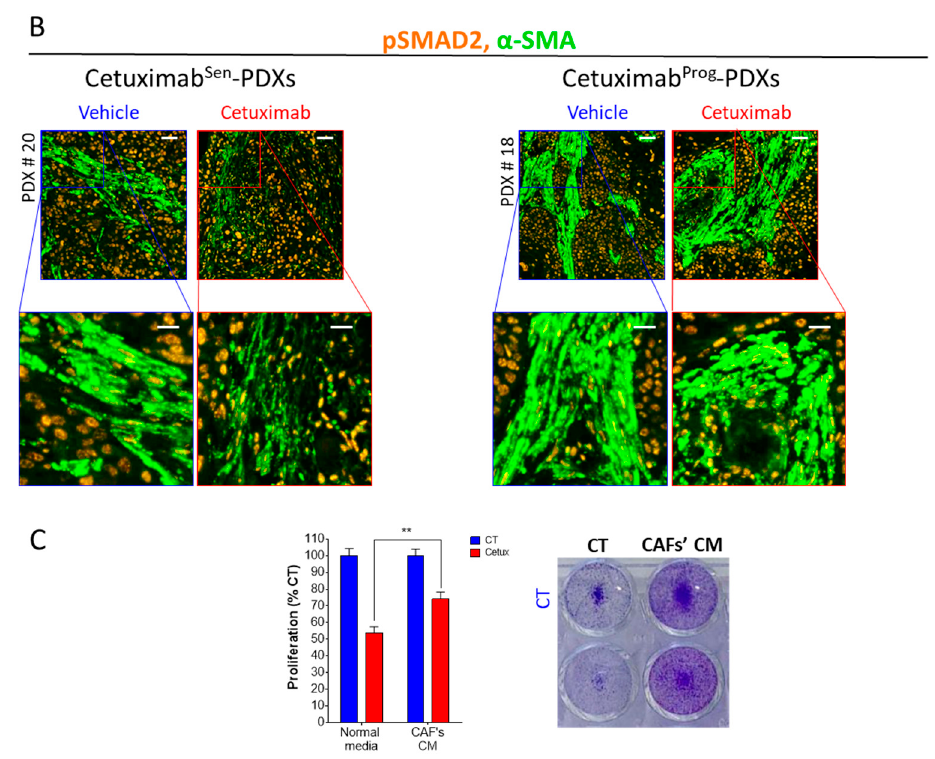
Figure 3. Tumor progression under cetuximab treatment is associated with TGF-beta activation in cancer-associated fibroblasts (CAFs). ( A ) Representative images of IHC staining for phosphorylated SMAD family member 2 (pSMAD2) of Cetuximab Sen -PDX and Cetuximab Prog -PDX. Scale bar: 20X, 50 μ m and 82X, 10 μ m, respectively. The expression levels were analyzed using the 3DHISTECH software HistoQuant, comparing 18–45 different regions, depending on the size of the tissue, in the stroma of the vehicle and cetuximab treatment groups. Statistical significance was calculated by unpaired t -test. * p < 0.05 and ** p < 0.01. ( B ) Opal costaining images of Cetuximab Sen -PDXs and Cetuximab Prog -PDX showing alpha-smooth muscle actin ( α -SMA) (Fluorescein isothiocyanate (FITC)-labeled) in green and pSMAD2 (Cy5-labeled) in orange. Scale bar: 20X, 50 μ m and 61X, 20 μ m, respectively. ( C ) Four days proliferation assay testing cetuximab (12.5 μ g/mL) efficacy in the Detroit562 HNC cell line, with and without conditioned media (CM) from PDX #19 CAFs (50% CM). The proliferation experiment was assessed in 3 independent experiments; the pooled results of the 3 experiments are presented. Statistical significance was calculated using unpaired t -test (* p < 0.05 and ** p < 0.01).